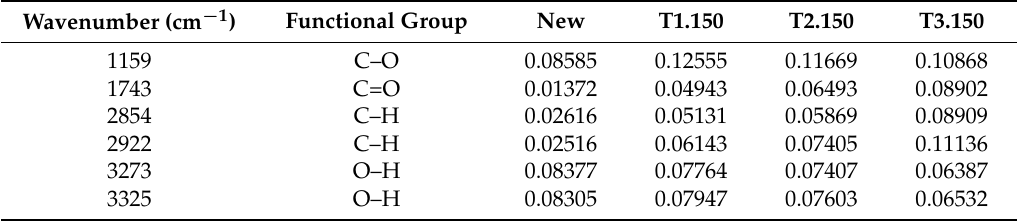
Table 4. Intensity of peak absorbance of functional groups of paper samples at temperature 150 °C.